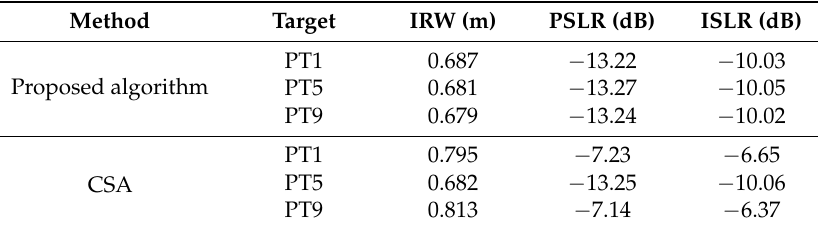
Table 2. Imaging quality parameters in Simulation Case I.